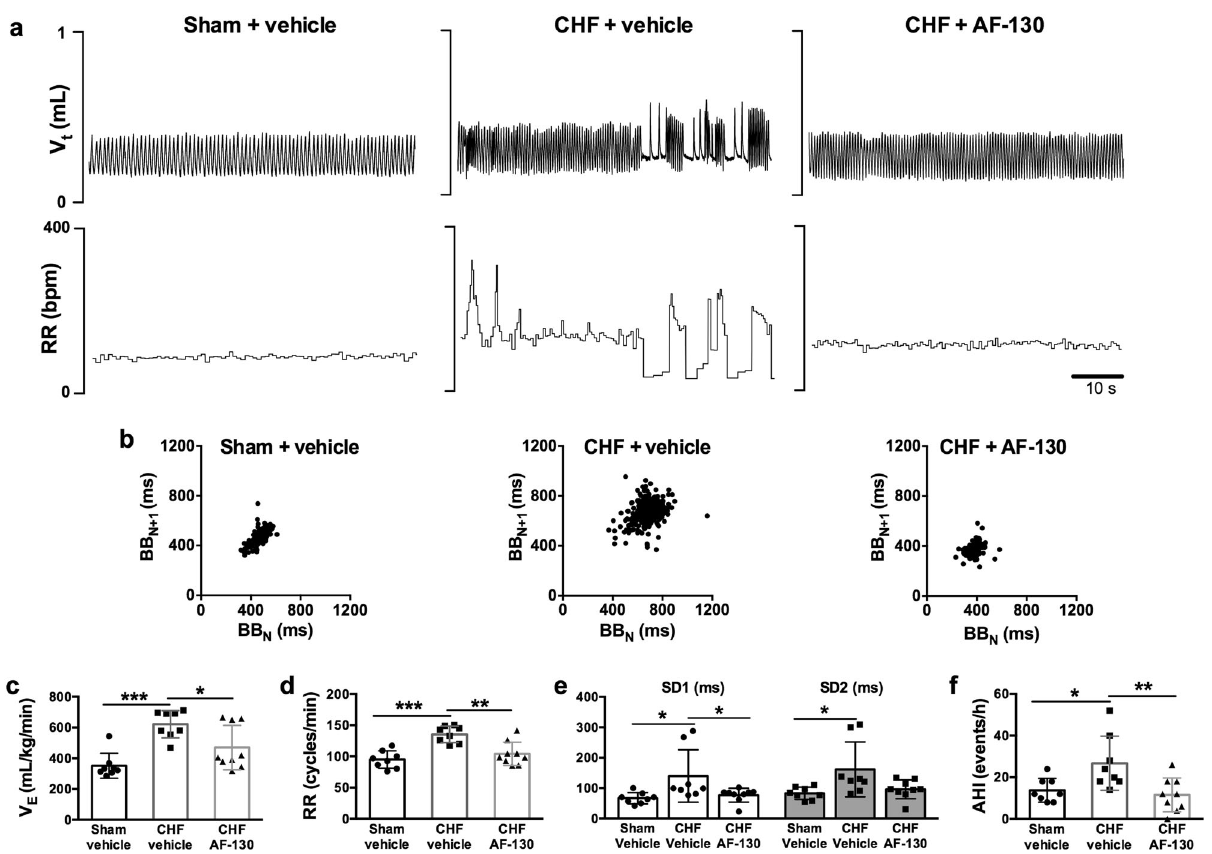
Fig. 2 | Chronic P2X3-receptor antagonism restored normal breathing pattern in chronic heart failure (CHF) rats. a Representative tracings displaying tidal volume (V t ) and respiratory frequency (RR) recorded in conscious rats using ple- thysmography and b Poincaré plots for breath-to-breath interval (BB N ) versus the subsequent interval (BB N+1 ). Breathing instability in CHF rats is demonstrated in V t and RR tracings, and higher breathing variability in CHF rats. P2X3-receptor